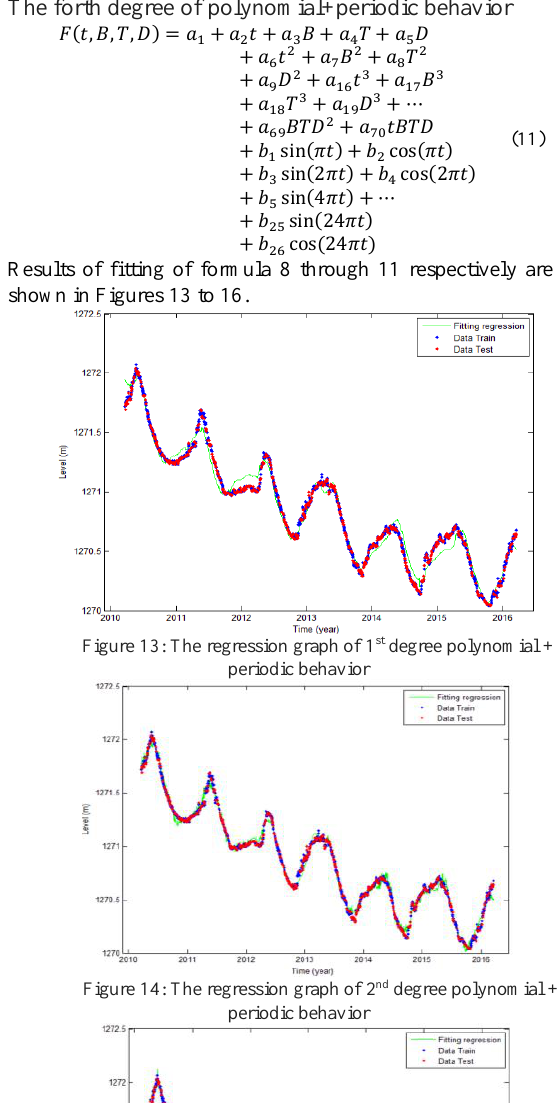
Figure 15: The regression graph of 3 rd degree polynomial + periodic behavior